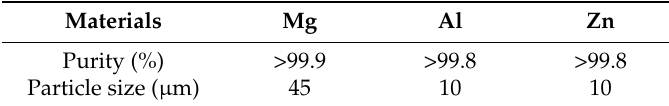
Table 1. Purity and particle sizes of metal powders used in this